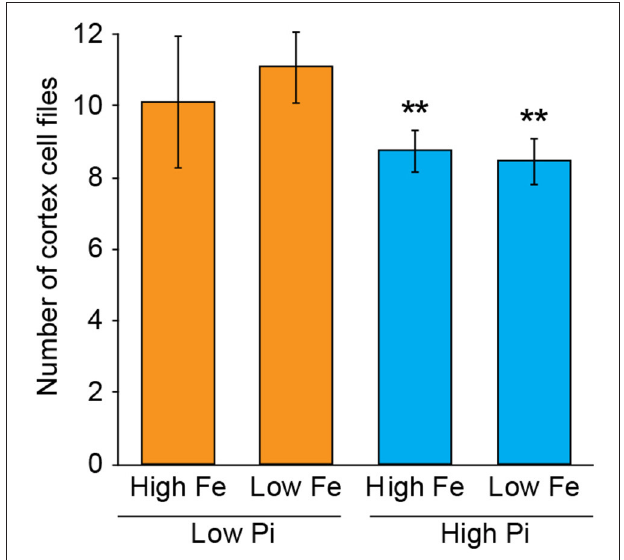
FIGURE 3 | Exposure to low Pi with low iron maintains the CCFN response of Arabidopsis roots to low Pi. Pseudo-Schiff propidium iodide stained roots imaged using confocal microscopy to generate optical transverse cross sections. Bar chart showing average CCFN for each treatment: LPHFe, CCFN = 10, n = 11; LPLFe, CCFN = 11, n = 11; HPHFe, CCFN = 8.75, n = 12; HPLFe, CCFN = 8.45, n = 11. Error bars represent standard deviation. **Statistically significant difference from HPHFe ( p ≤ 0.001); *statistically significant difference from HPHFe ( p ≤